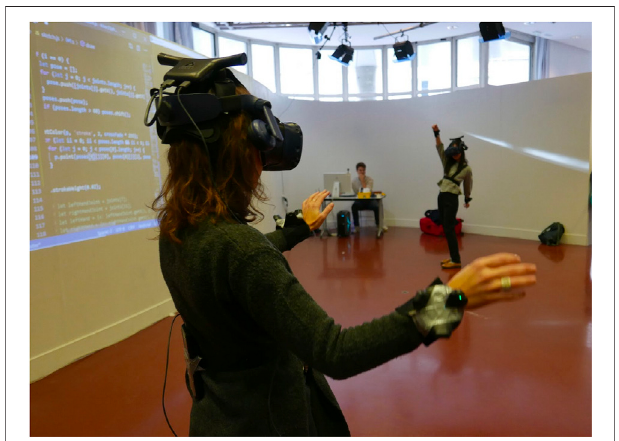
FIGURE 2 | On the right: Articulations team preparing the performance with two hip-hop dancers.